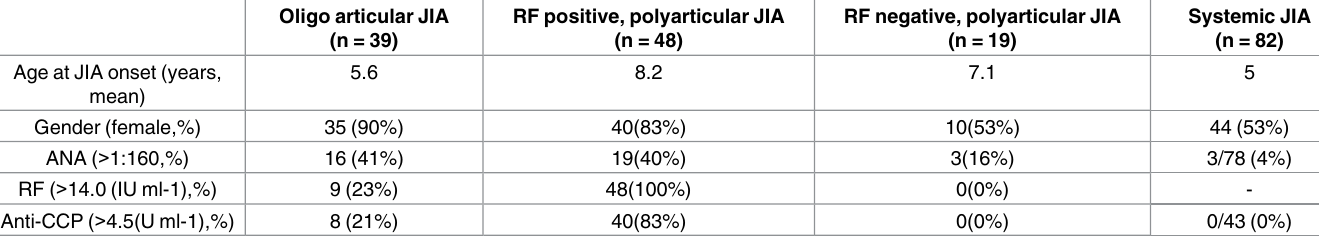
Table 1. Clinical characteristics of JIA patients.